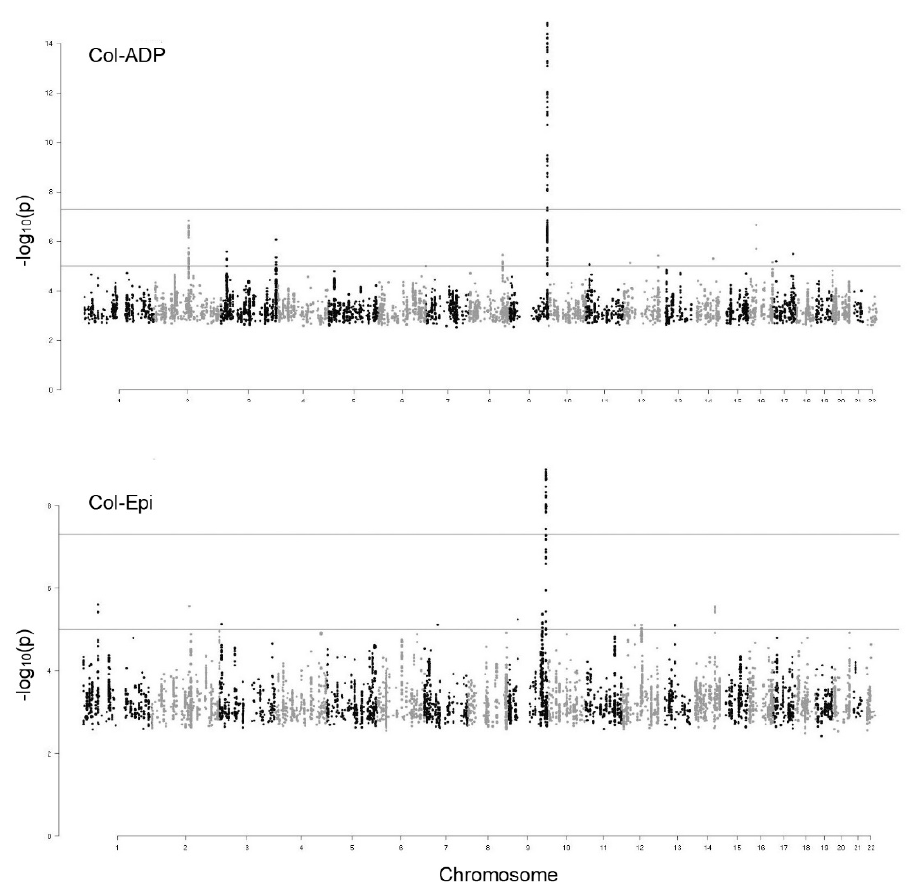
Figure 1. Manhattan plots of the GWAS on two PFA-100 phenotypes: collagen-ADP and collagen epinephrine closure times. Dots correspond to SNPs organized by chromosomal order and position and the vertical axis shows the statistical significance expressed as − log 10 of the p -values. The horizontal lines mark the 5 × 10 − 8 p -value threshold of genome-wide significance.